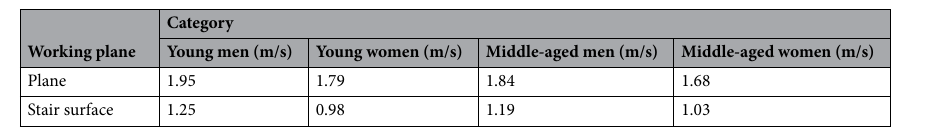
Table 5. Evacuation speed of different types of personnel on different working surfaces.